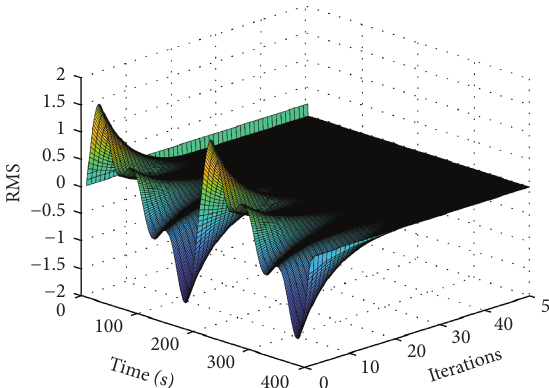
Figure 9: Error trajectory in both time and iteration domain (with actuator